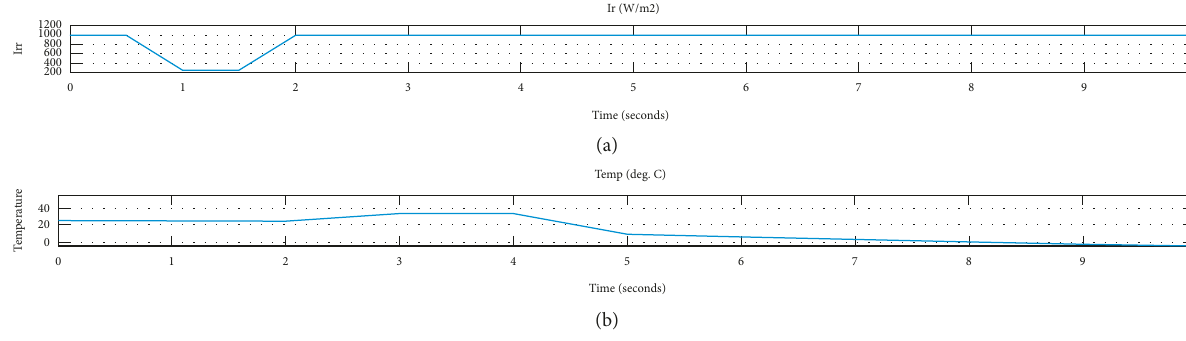
Figure 7: Environment conditions: (a) solar PV array input irradiance and (b) module temperature.